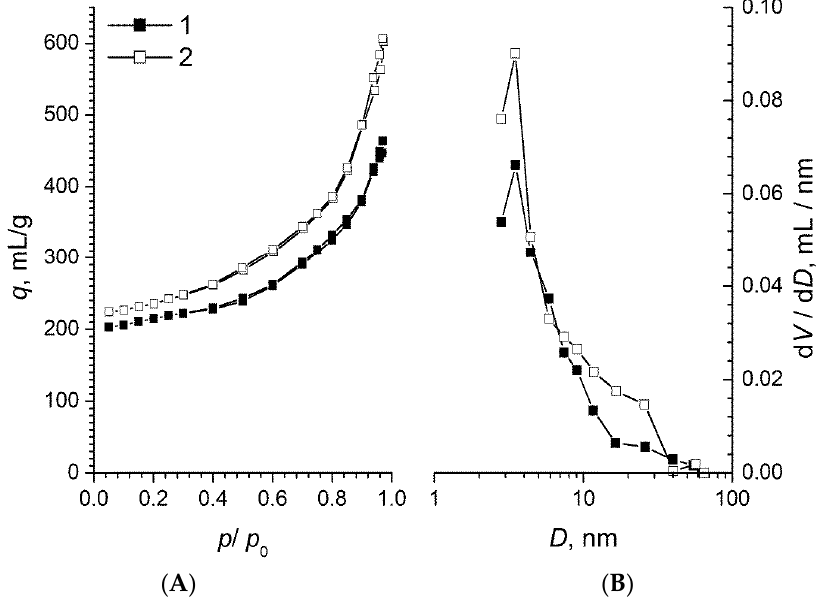
Figure 2. Full adsorption–desorption isotherms ( A ) and pore size distributions ( B ) for RF-700 (1) and RF-1100 (2) samples.